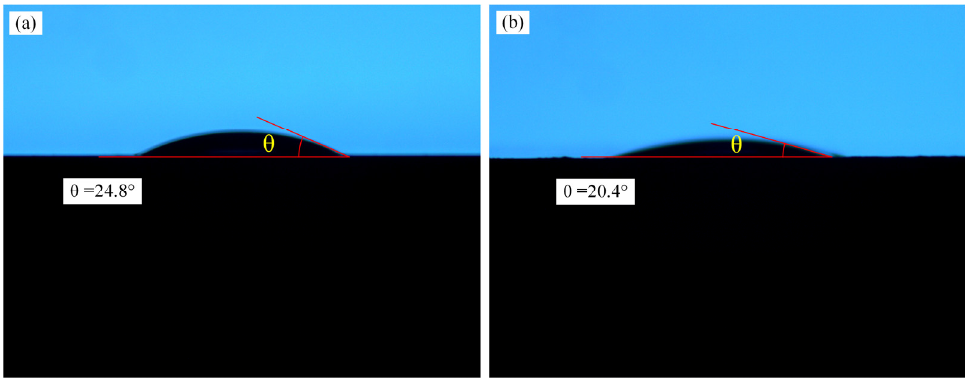
Figure 7. Contact angles of ( a ) cladding layer and ( b ) nitriding